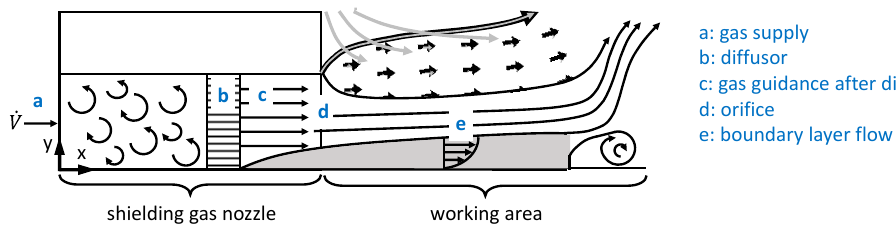
Figure 1. Model concept of fluid mechanics of shielding gas supply using the example of a flat jet nozzle. The gas supply (a) transports the shielding gas from gas cylinder to nozzle. Due